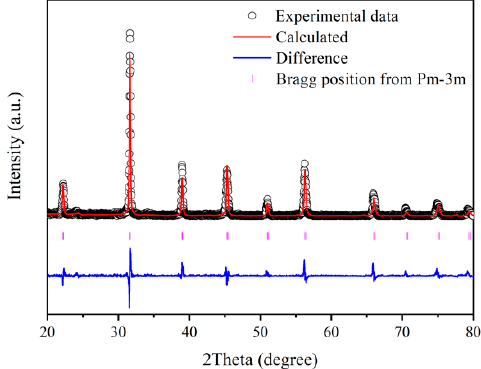
Figure 2. Rietveld refinement analysis of the BaTiO 3 powder.